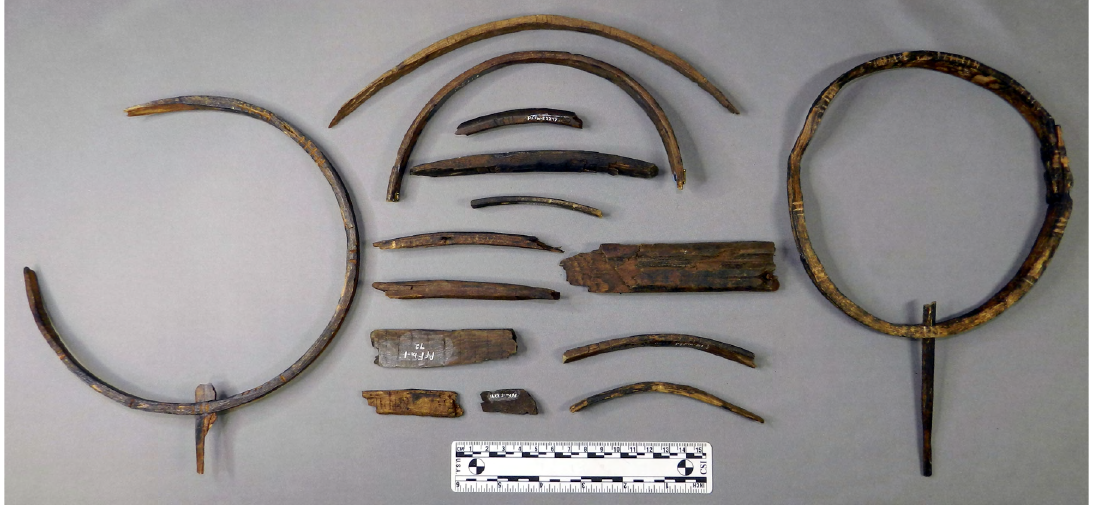
Figure 4. Dorset drum frames and drum frame fragments from Button Point (PfFm-01:1749, PfFm-01:1750, PfFm-01:54, PfFm-01: 50, PfFm-01:51, PfFm-01:1752, PfFm-01:1808, PfFm-01:1875, PfFm-01:2081, PfFm-01:2277, PfFm-01:68, PfFm-01:70, PfFm- 01:72, PfFm-01:76, PfFm-01:2291). Photo by Tim Rast. Canadian Museum of